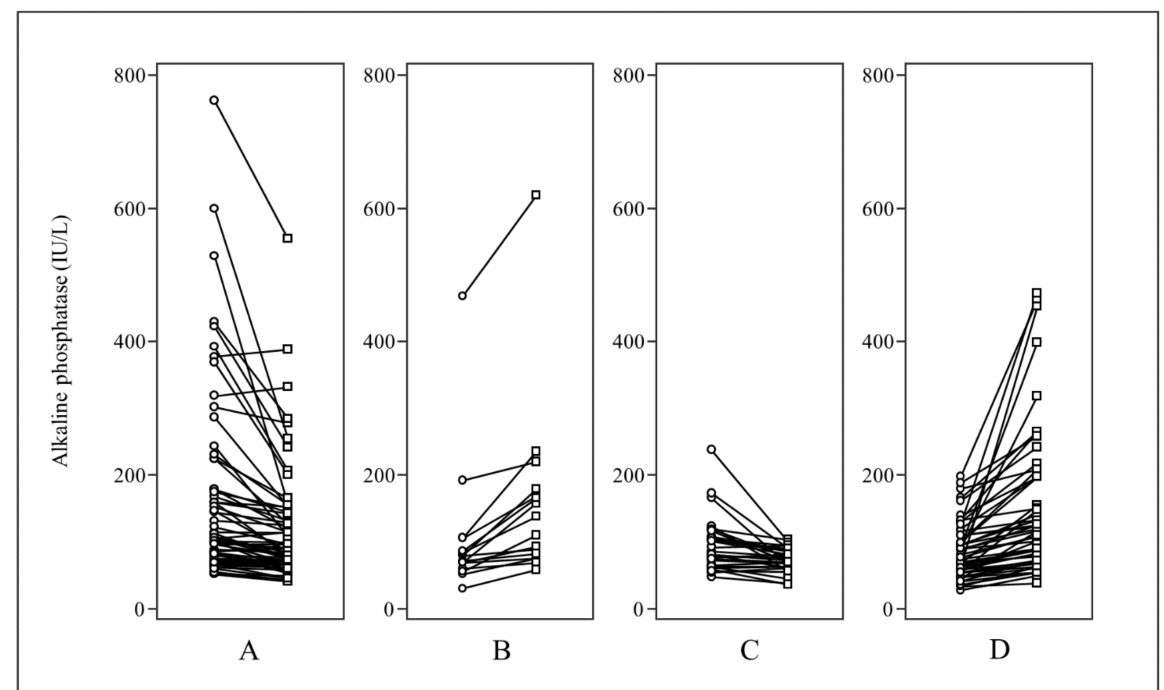
Figure 3. Dot and line graphs for directional changes in ALP. The dot and line graphs show individual directional change in the ALP of patients in the flare group for ( A ) stable/decreased ALP and ( B ) increased ALP, and in the progression group for ( C ) stable/decreased ALP and ( D ) increased ALP. The incidence of stable/decreased ALP was higher in the flare group than in the progression group (64/80, 80.0% vs. 29/80,